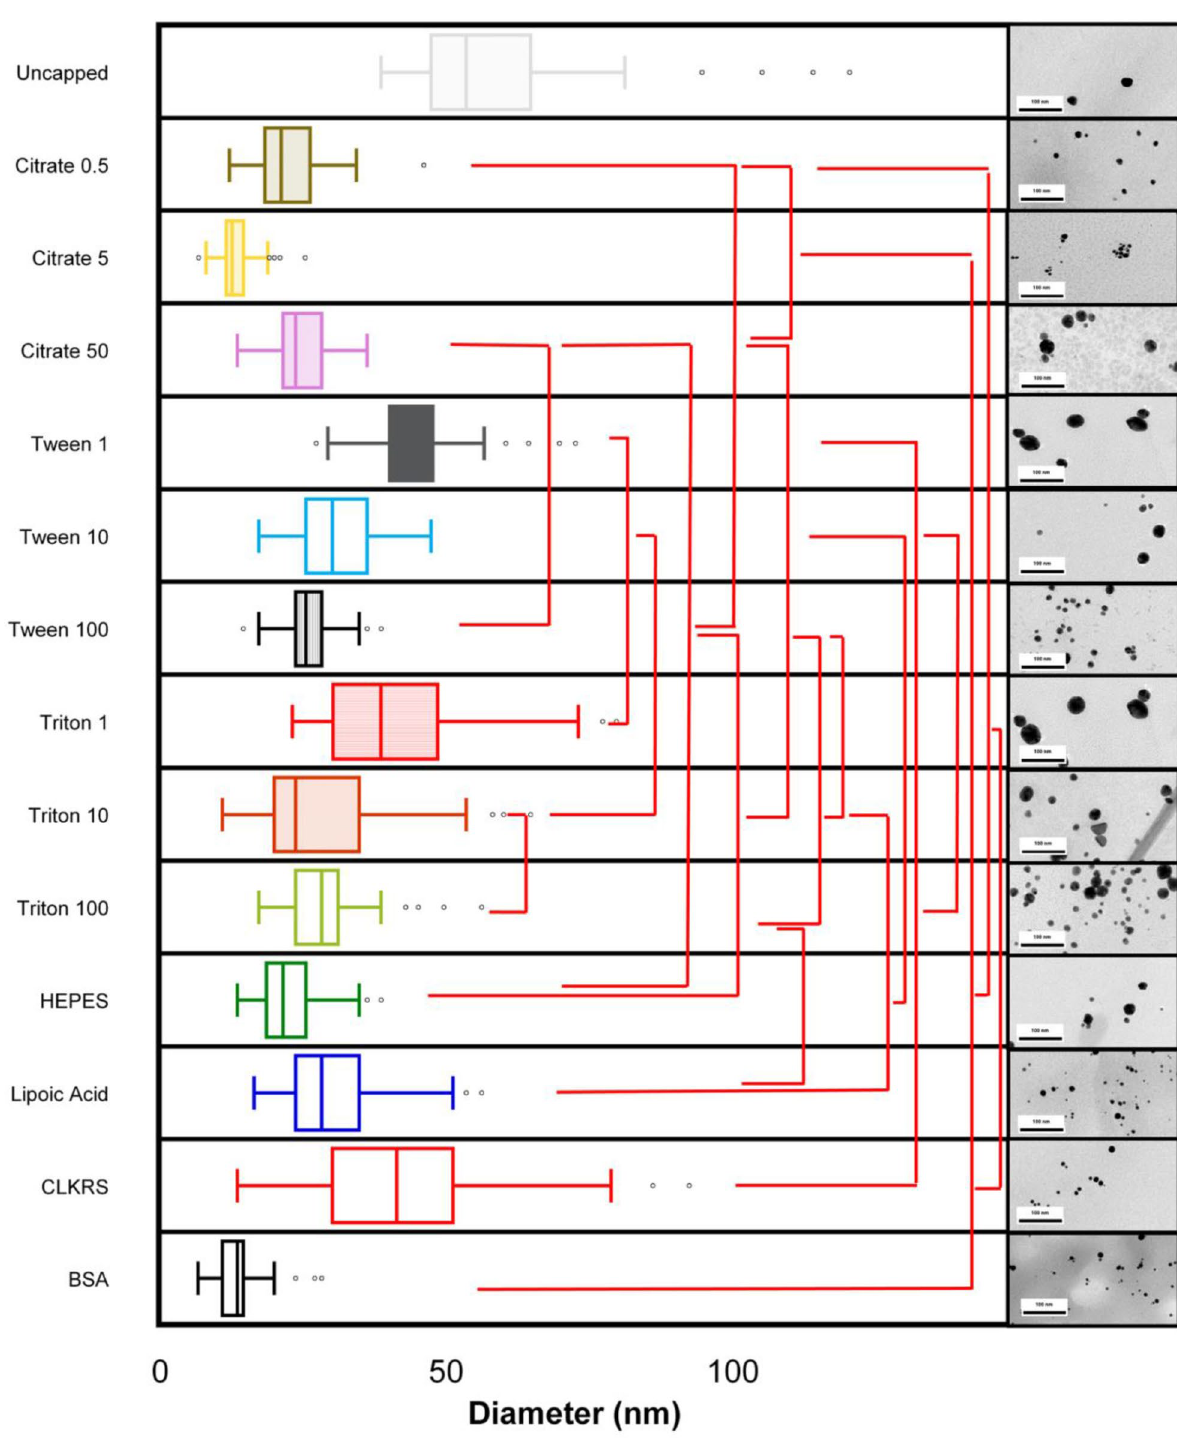
Figure 3. Transmission electron microscopy images for nanogold and nanosilver prepared using NPFloSS. Nanogold TEM measurements corroborate DLS measurements with regards to particle size for nanoparticle samples made by NPFloSS. The type of nanoparticle, capping agent used, and number of equivalents for the capping agent are presented to the left side of each histogram. Each histogram represents 30–100 individually measured nanoparticles. Representative TEM images of the nanoparticles are shown to the right of each histogram along with a 100 nm scale bar. Values in the figure are represented as box plots where the box encloses 50% of the data, upper and lower quartile, with the median value of the variable displayed as a line inside the box. The bars extending from the top and bottom of each box mark the minimum and maximum values within the data set that fall within an acceptable range. p values are calculated by one-way ANOVA using Holm’s multiple comparison analysis. Bars in red indicate no statistically significant differences (see Table